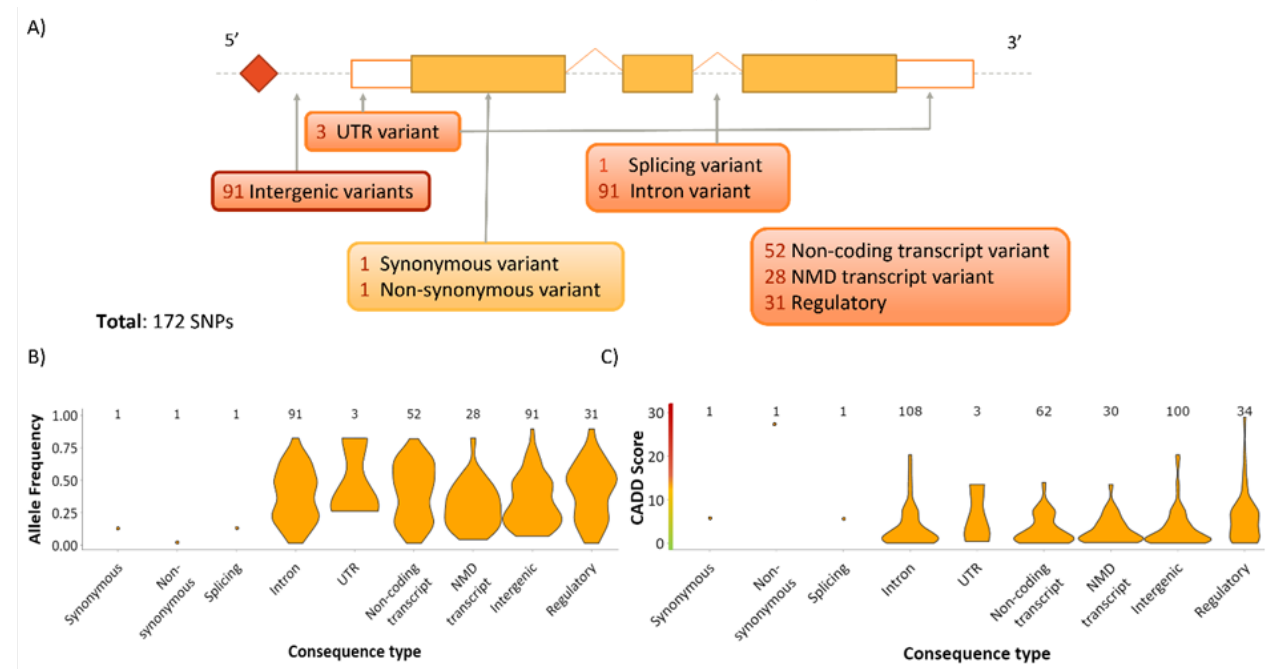
Figure 1. MD GVs are mostly non-coding, common, and potentially not pathogenic. ( A ) GVs distributed along the genome according to their consequence type predicted with VEP. ( B ) Allele frequency density, according to GV’s consequence type, also predicted with VEP. ( C ) Pathogenicity score (predicted by CADD) density per consequence type. Please note that a GV can have multiple consequence types; thus, the number of consequence types may not necessarily match the total number of GVs. MD: major depression; GV: genetic variant; VEP: Variant Effect Predictor; CADD: Combined Annotation Dependent Depletion; SNP: single nucleotide polymorphism; UTR: untranslated region; NMD: nonsense- mediated decay.